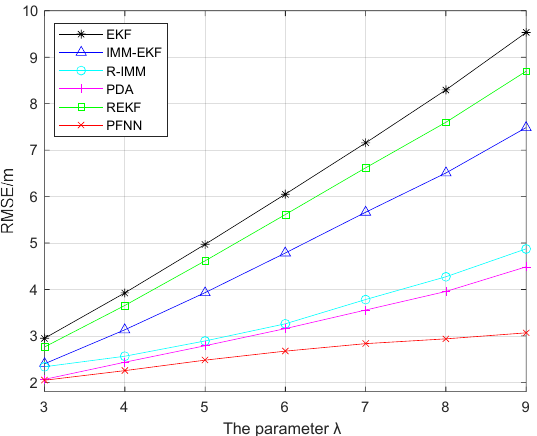
Figure 8. The RMSE versus parameter λ.